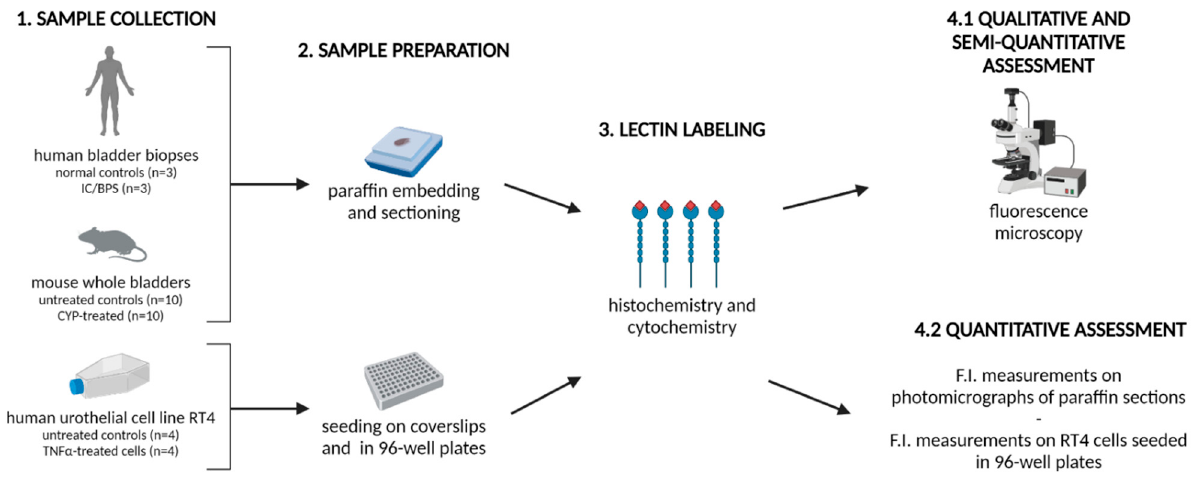
Figure 1. Schematic illustration of experimental design. The illustration was designed using Bioren- der.com (accessed on 16 March 2022). F.I., fluorescence intensity.